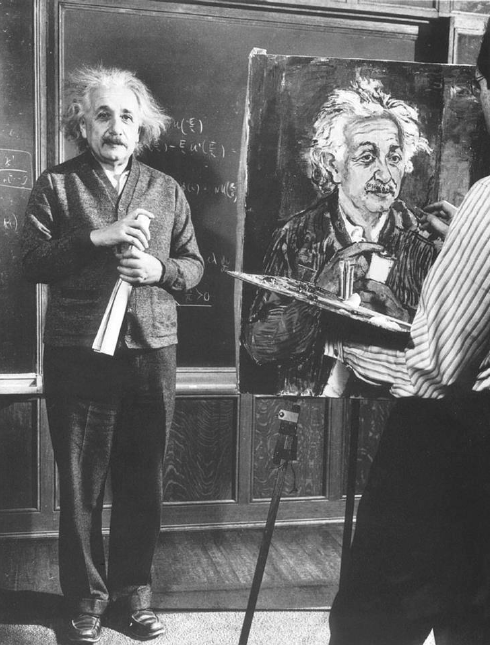
Figure 2. Albert Einstein posing for a portrait painting. Taken from